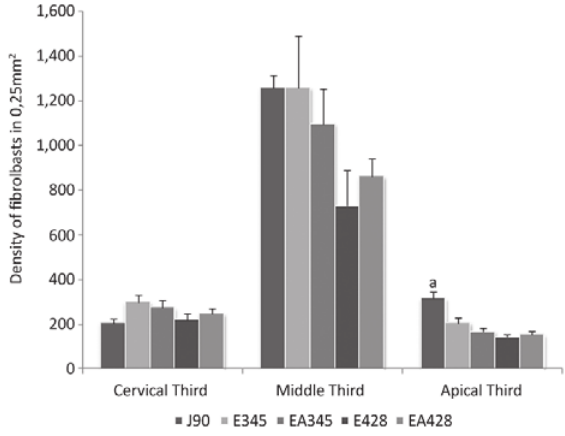
Figure 3 - Density of fibroblasts in cervical, middle and apical thirds of the root observed in groups: J90 (90-day-old young rats), E345 (345-day-old aged rats), EA345 (345-day-old aged rats treated with ascorbic acid since 90-day-old), E428 (428-day-old aged rats) and EA428 (428-day-old aged rats treated with ascorbic acid since 90-day- old). n = 5 rats per group. a P < 0.05 when compared to the other groups.